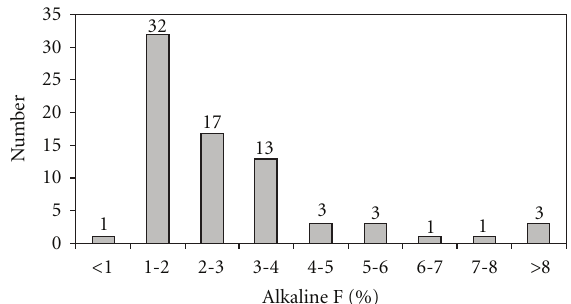
Figure 2: Hemoglobin F distribution in 74 individuals with homozygous Hb